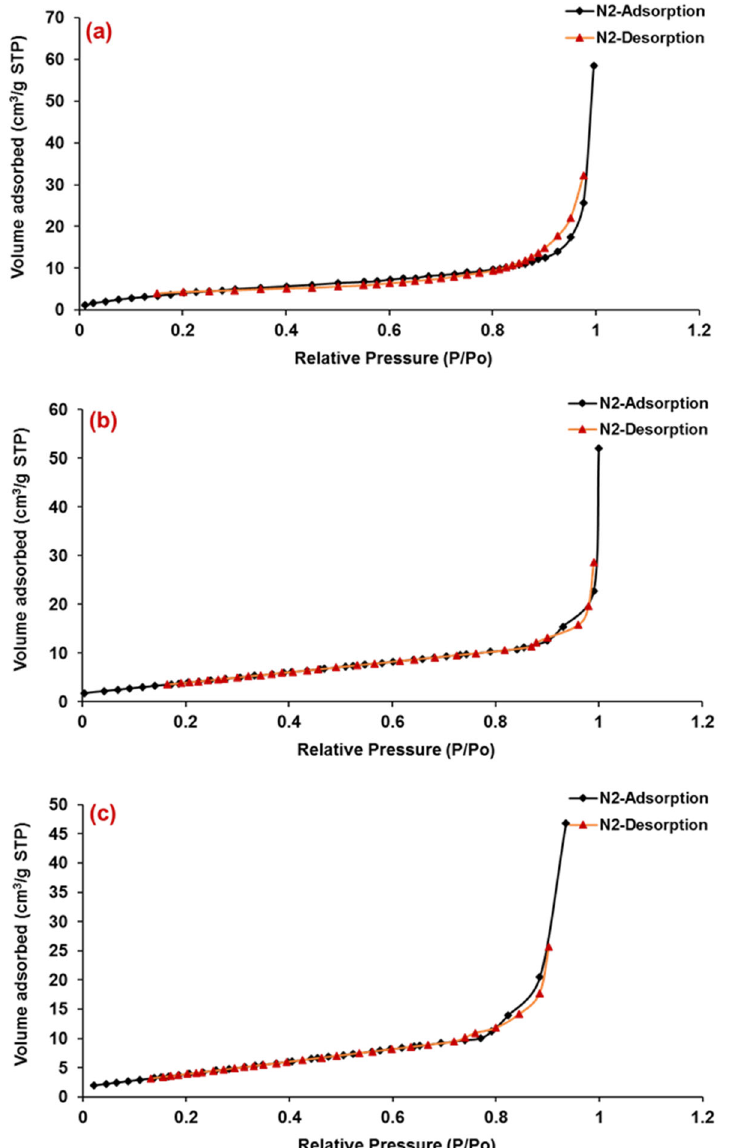
Figure 3. Nitrogen (N 2 ) adsorption–desorption isotherm of macroporous SEMC ( a ), 5-FU-loaded SEMC (F2) ( b ) and ERS-coated 5-FU-loaded SEMC (F2-ERS) ( c ). All measurements were performed at 77 K.